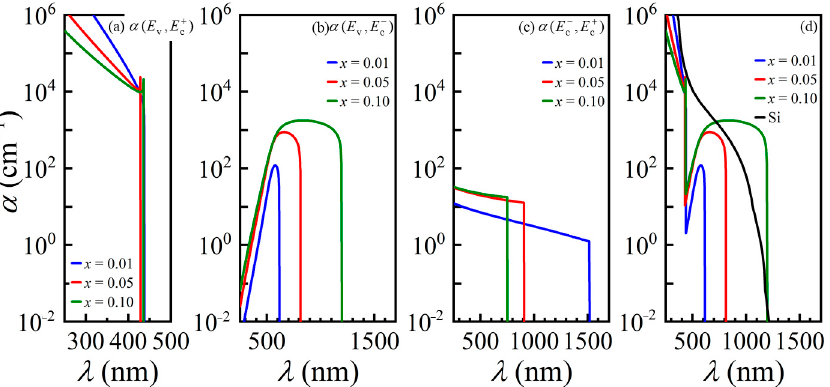
Figure 3. Absorption spectra ( α ) for bulk GaP-lattice-matched GaN x AsP. ( a – c ) Three-section absorption spectra for N = 0.01 to N = 0.1 with E − c as an IB; indexes represent the initial and final bands of the absorption process: valence ( E v ), E + c , and E − c bands; ( d ) Absorption spectrum of GaNAsP as a single-band-gap material with different mole fractions of N. Absorption spectrum of a single-band-gap GaNAsP is the sum of α ( E v , E + c ) and α ( E v , E − c ). The absorption spectrum of Si is also shown in Figure 3d.